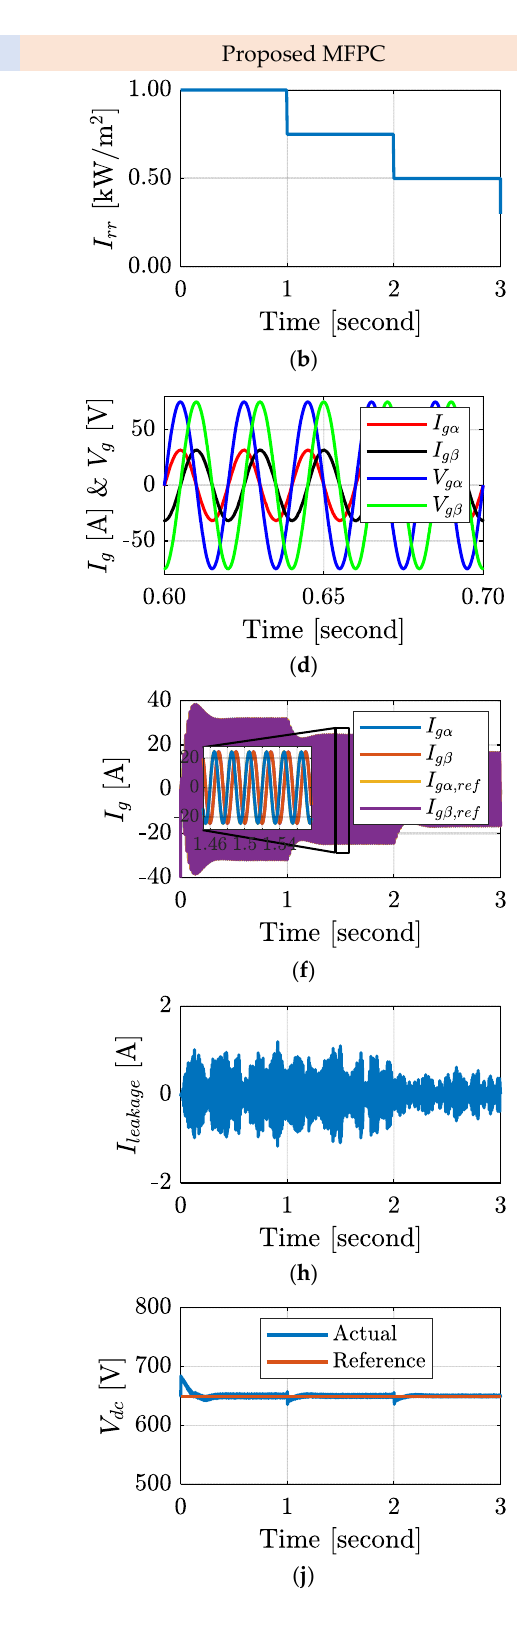
Figure 8. Suggested NPC transformerless inverter’s grid voltage, grid current, irradiation, earth leakage current, and DC link voltage simulation findings for conventional SVPWM with PI current controller and MFPC